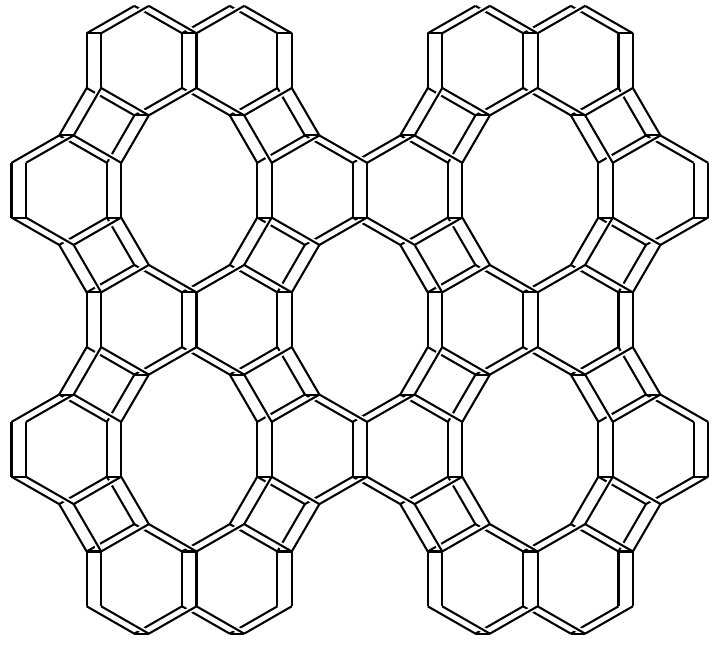
Figure 1. Structural framework of the aluminophosphate AlPO 4 -11 viewed along (100) direction.